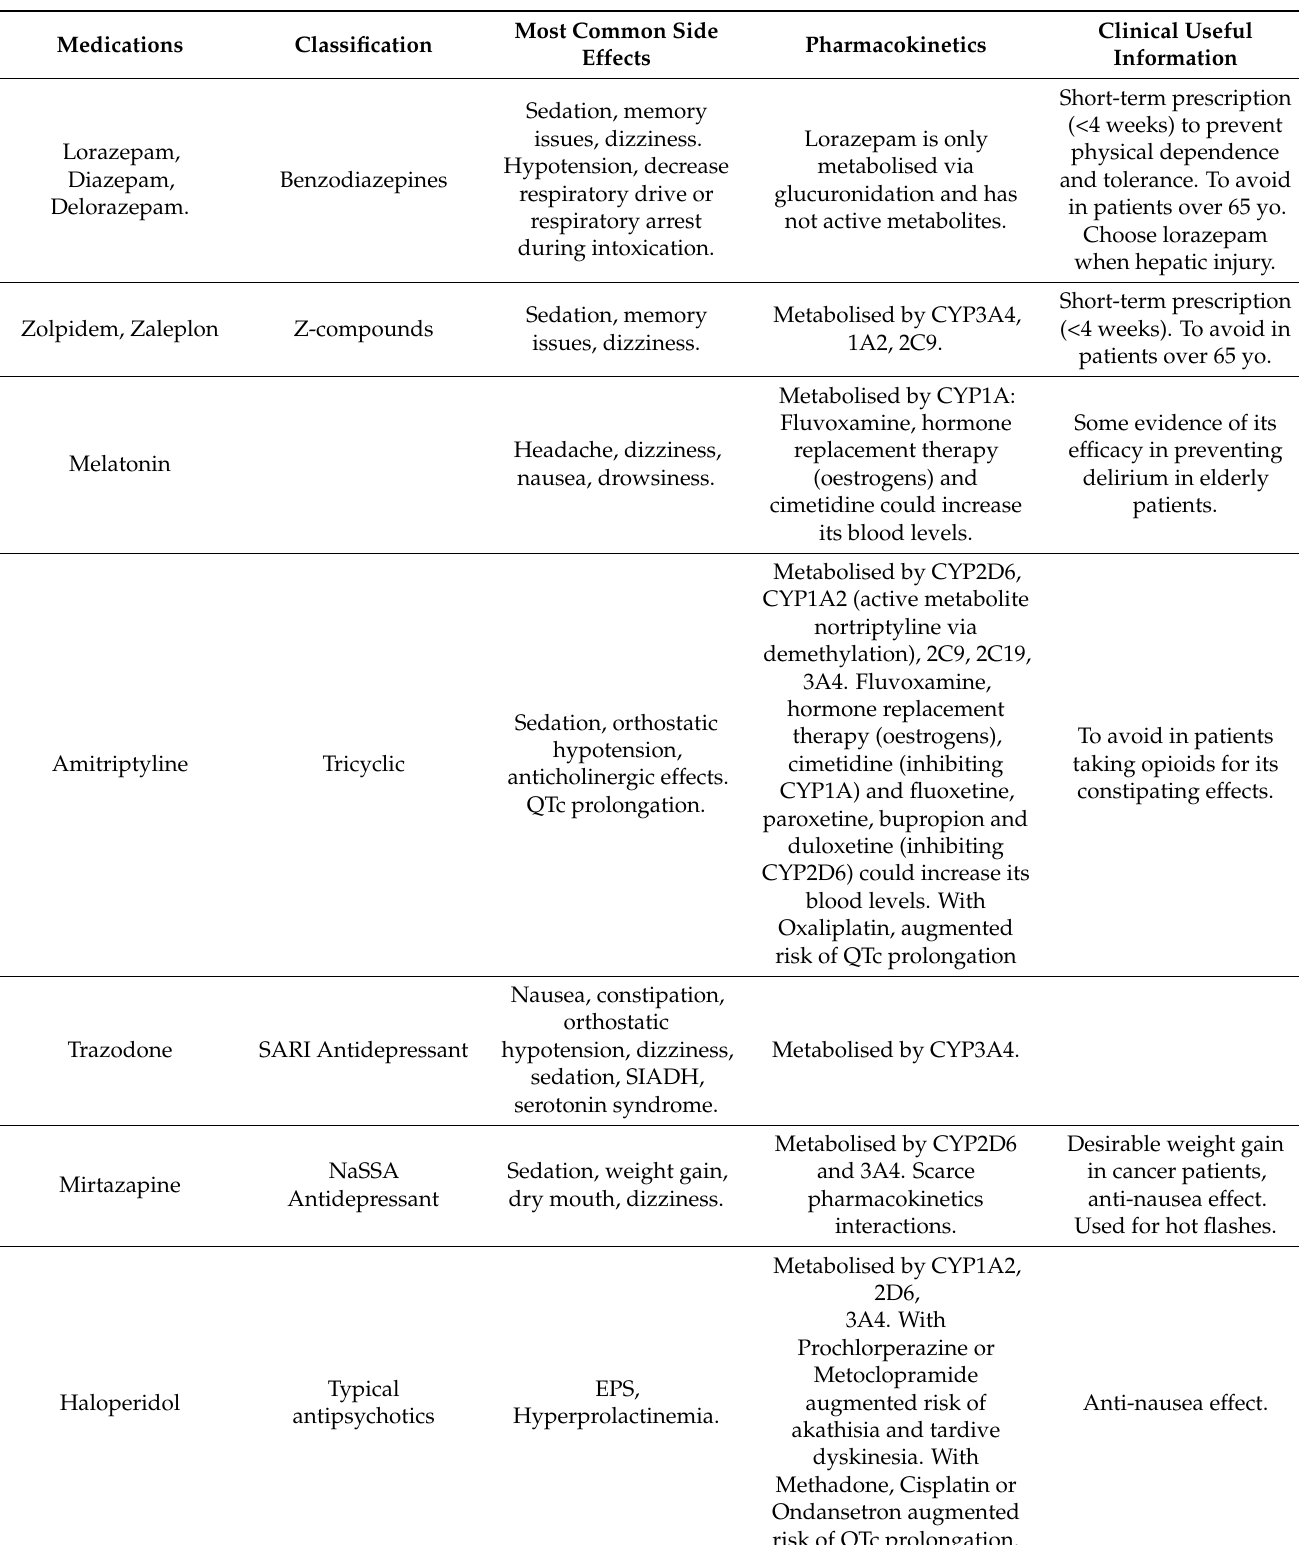
Table 2. Main characteristics of the most frequently prescribed compounds for the treatment of insomnia in cancer